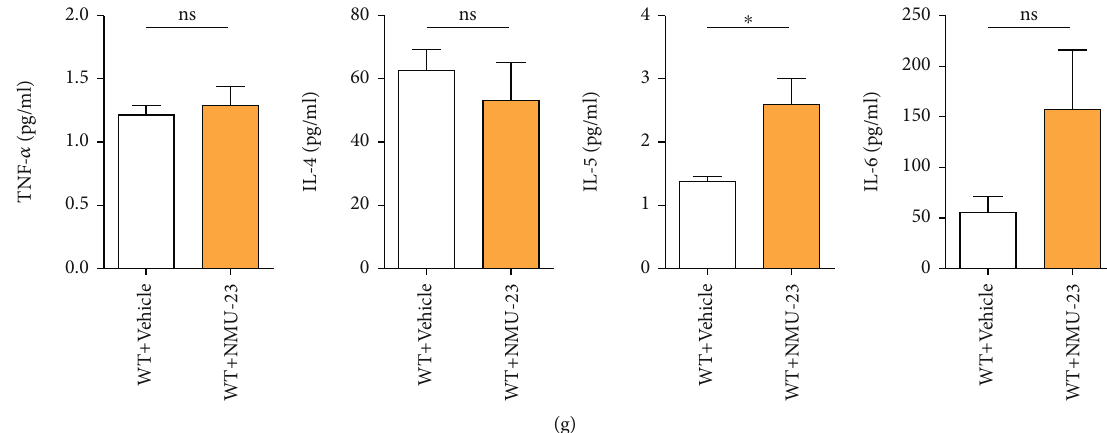
Figure 2: NMU-23 induced ILC2 expansion and Th2 responses in the joint of arthritic mice. (a) Gating strategy for the identi fi cation of total ILCs (CD45 + Lineage - CD127 + ), ILC1 (NK1.1 + T-bet + ), ILC2 (KLRG1 + ICOS + ), and ILC3 (NK1.1 - ROR γ t + ) in mesenteric lymph node (mLN) of arthritic mice. (b – d) The frequency of ILC2 (b), ILC1 (c), and ILC3 (d) in the joint, mLN, and spleen of arthritic mice. (e) Representative fl ow cytometry plot and quanti fi cation of eosinophils (CD45 + SiglecF + ) in the joint of arthritic mice. (f) The percentage of Th2 cells in mLN and spleen of arthritic mice. (g) Sera TNF- α , IL-4, IL-5, and IL-6 levels were determined by Luminex. Data are shown as mean ± SEM ( ∗ P < 0 : 05 , ∗∗ P < 0 : 01 , and ∗∗∗ P < 0 : 001 determined by Student ’ s t